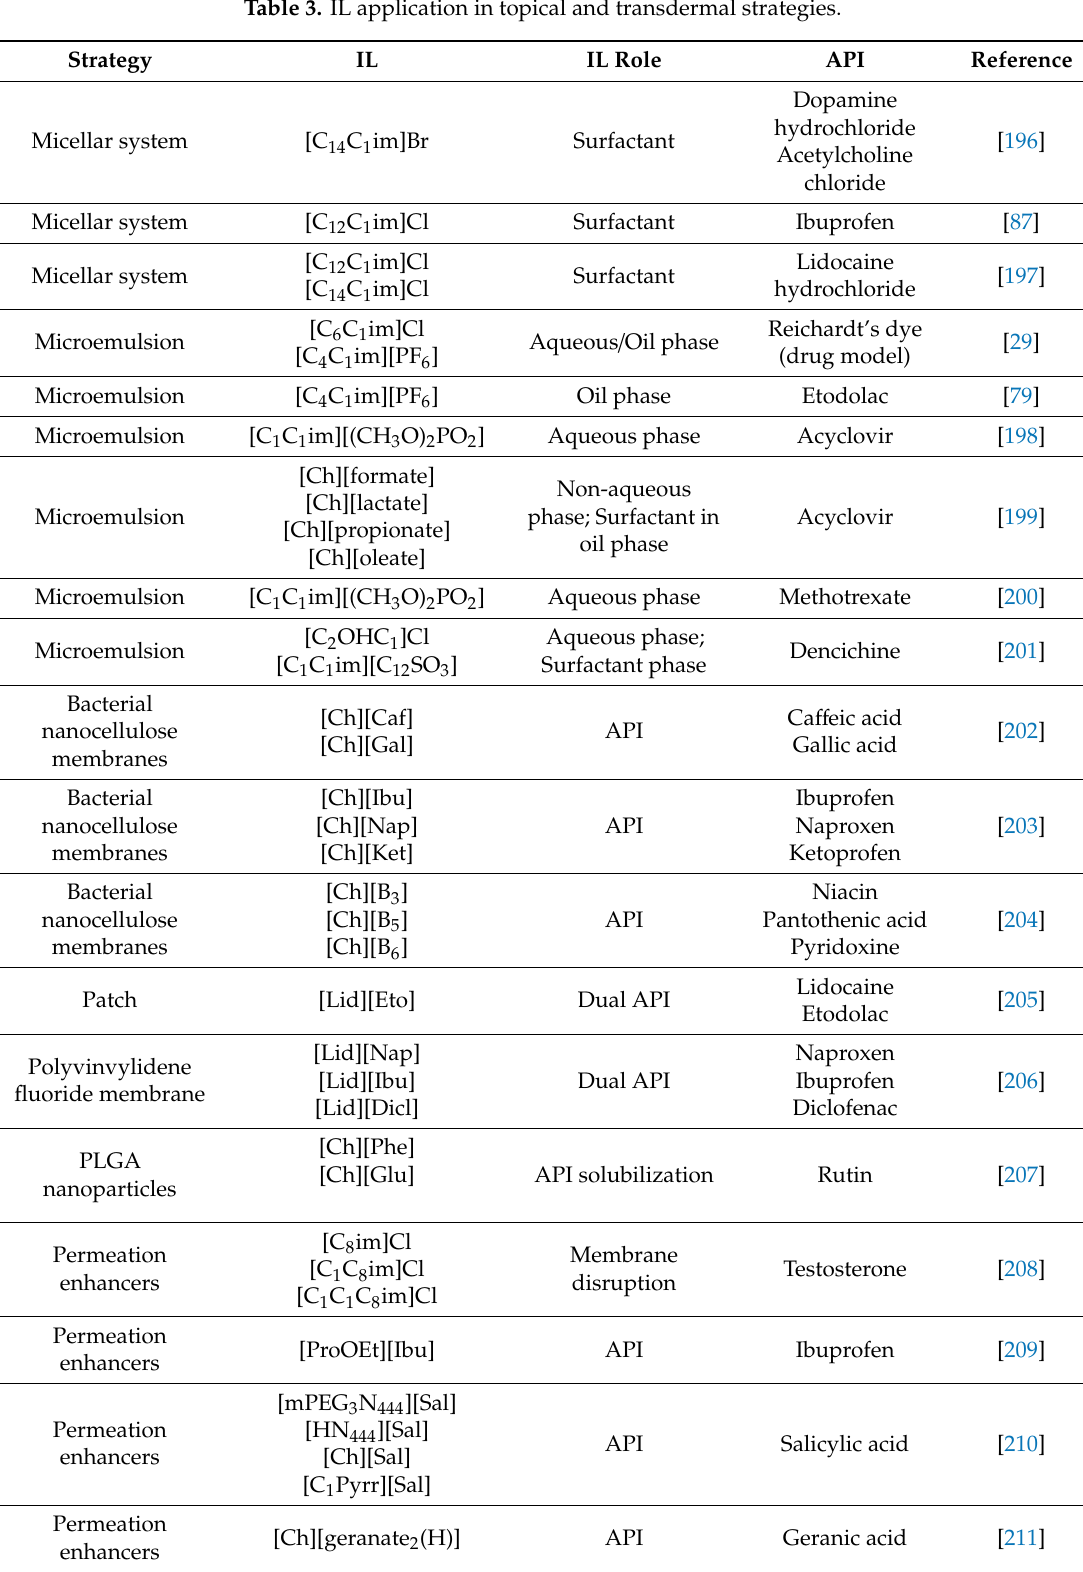
Table 3. IL application in topical and transdermal